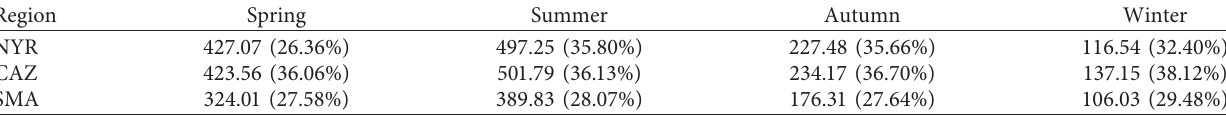
Table 4: The seasonal ET 0 (mm) and proportion (%) from 1957 to 2018 over the NYR, CAZ, and SMA. Region